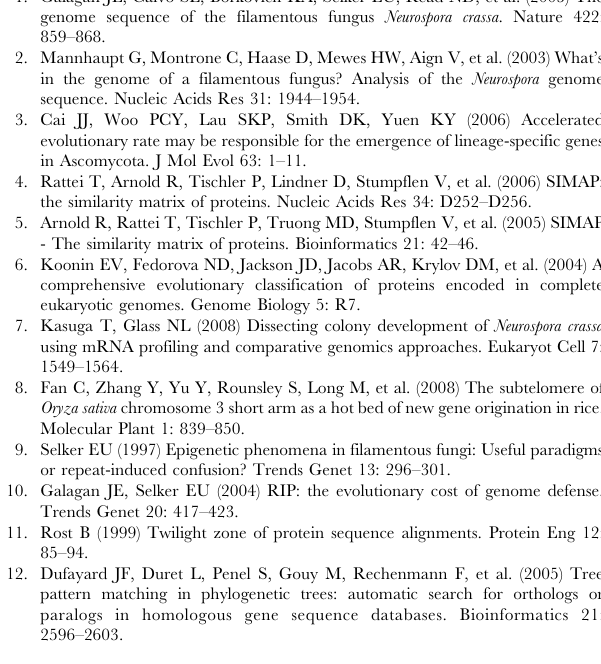
Figure S1 Histograms showing the relationship of percent similarity scores between N. crassa and C. globosum and the number (A) and percentage (B) of PCGs in each of the LS groups. Percent identity scores for number (C) and percentage (D) of PCGs are also shown for comparison. Note that although similarity scores are higher than identity scores, the trend is